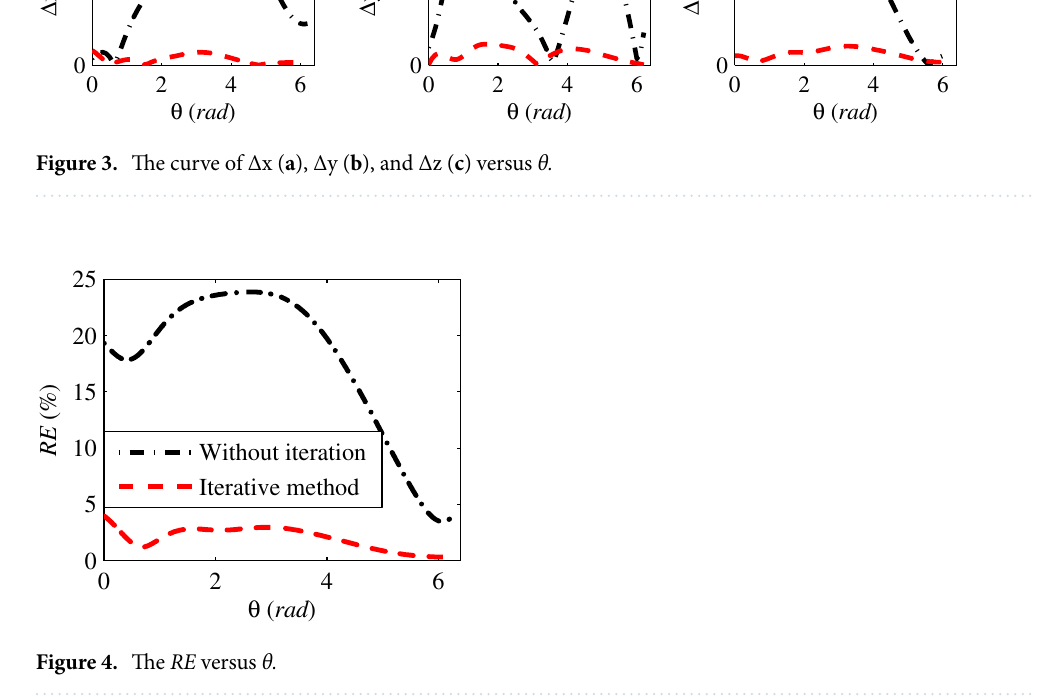
dashdot line (black) is without iteration and the dashed line (red) is with iteration. It can be seen in Fig. 3 that the localization accuracy is greatly improved by the iterative method. The maximum of Δx without and with iterative method is 1.83 m and 0.18 m, respectively, i.e., the localization accuracy is improved by up to 10 times by using the iterative method according x-axis. In the same way, the localization accuracy is improved by up to 6 times and 7 times with iterative method according y-axis and z-axis, respectively. Furthermore, the relative error ( RE ), which can be used to evaluate the accuracy of the estimated bearing vector similarity with respect to the ideal bearing vector, was defined as follows